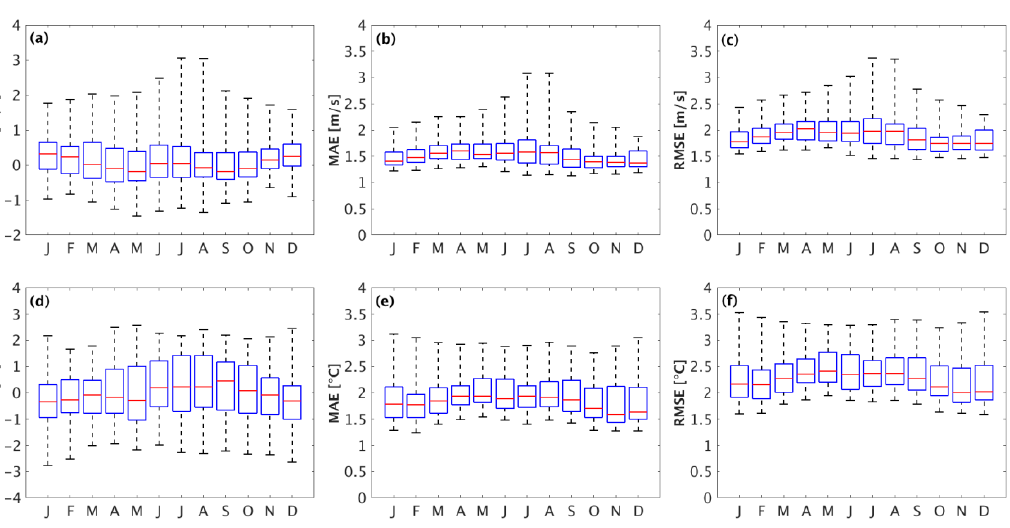
Figure 4. Inter-annual evaluation statistics for wind speed ( a – c ) and temperature ( d – f ). Central red marks indicate the median, the box edges indicate the range between the 25th and 75th percentiles and the whiskers indicate the minimum and maximum values, respectively.